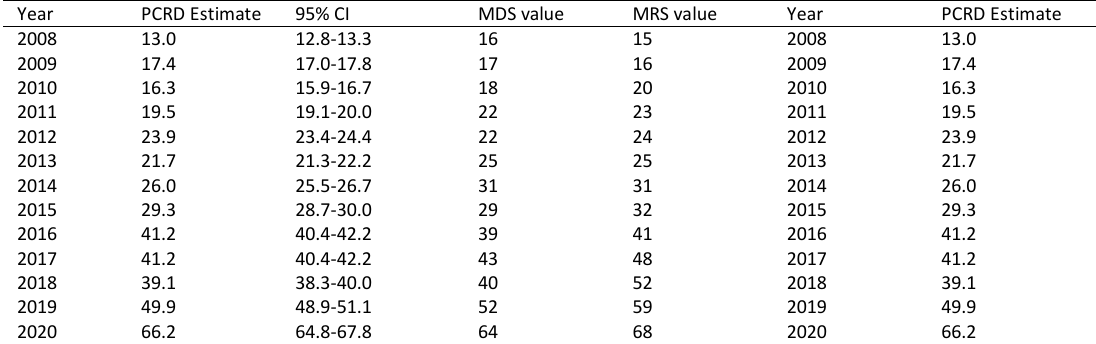
Table S6: Comparison of the annual abundance of the Pyrenean brown bear population, estimated from Bayesian Pollock’s robust design (PCRD) capture -recapture (CR) approach (with associated 95% Credible Interval), with Minimum Detected Size (MDS, total number of different individuals detected in the population during the year) and Minimum Retained Size (MRS, reassessment of the MDS in the light of the information collected in subsequent years) values from 2008 to 2020.